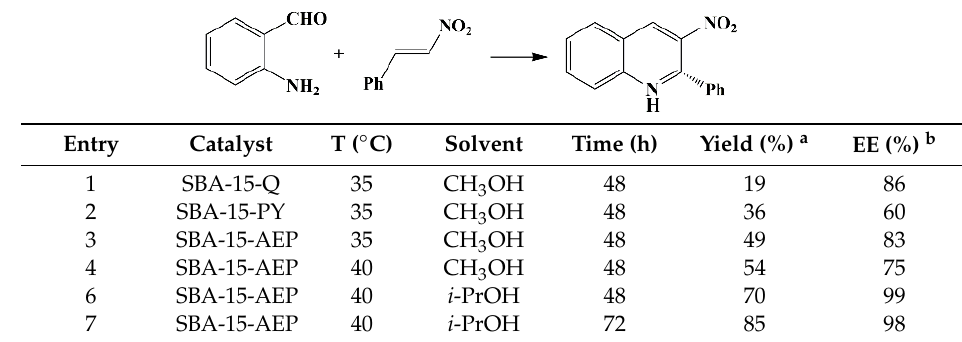
Table 1. The aza-Michael–Henry cascade reaction on designed bi-functional catalysts with tailored reaction